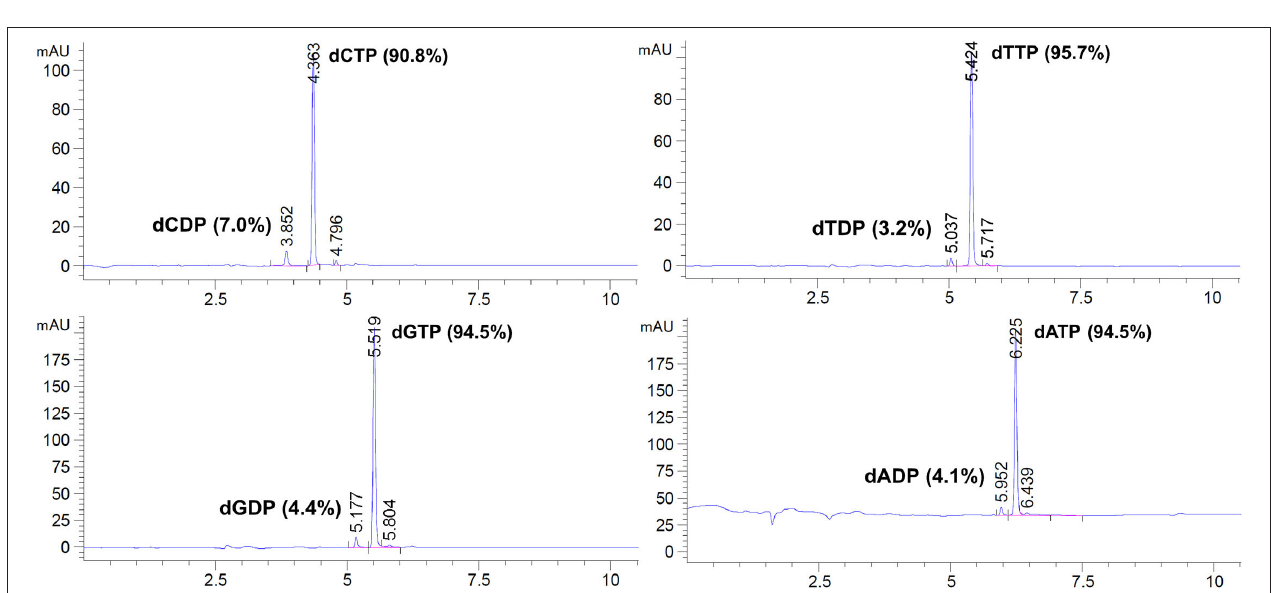
FIGURE 2 | Overview of the synthesis of the dNTPs. *Purity was determined by UV peak area at 260nm by reverse phase HPLC (details in text).